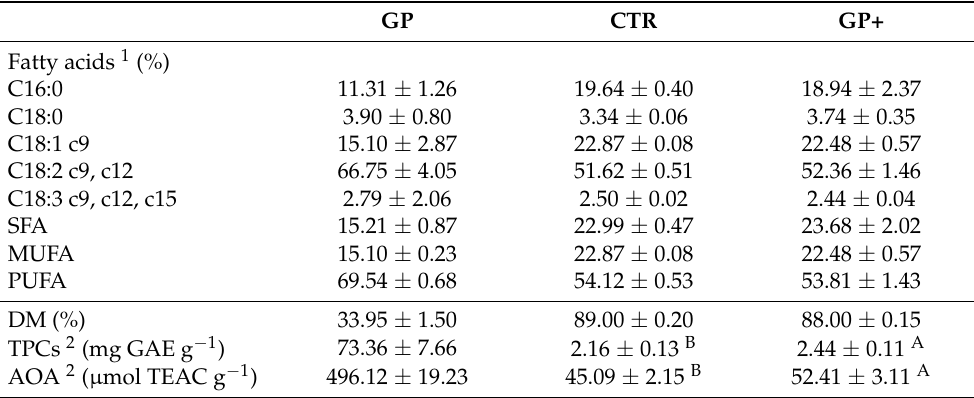
Table 1. Fatty acid profiles, total phenolic content and antioxidant activity of grape pomace (GP) and the custom-formulated diet for the control group (CTR) and experimental group (GP+).